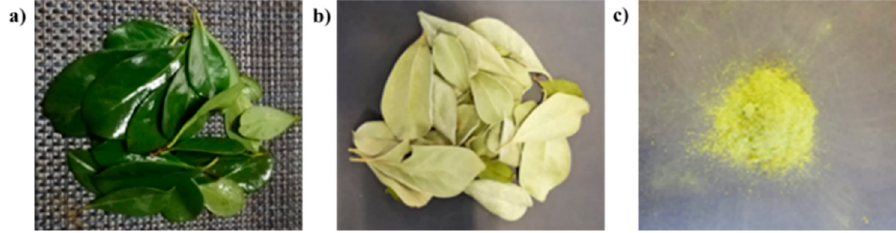
Figure 1. Fresh ( a ), dried ( b ), and powder leaves ( c ) of Psidium